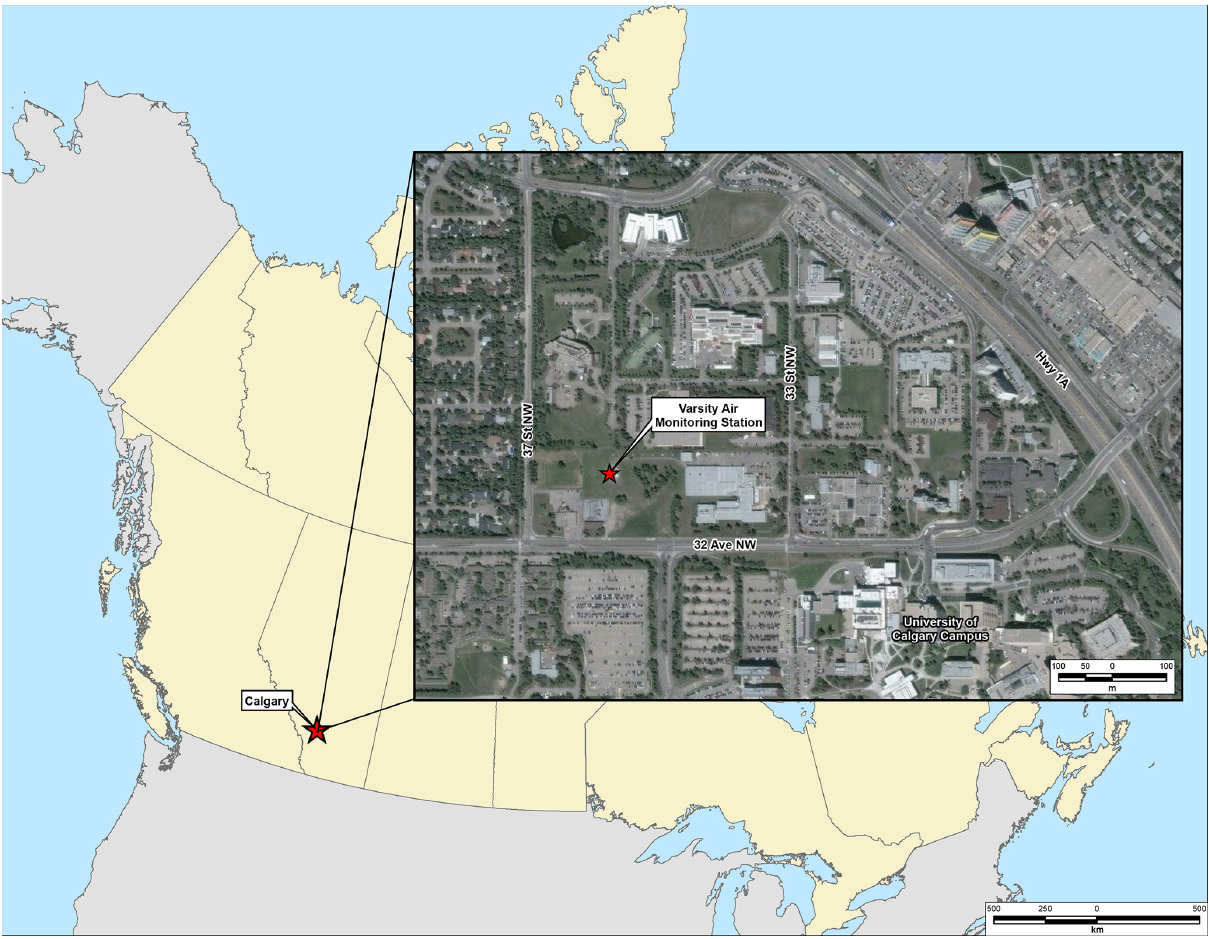
Figure 2. Location of the Varsity air monitoring station. The map was created using ArcGIS ® . The administrative boundaries in Canada and imagery data were provided by Natural Resources Canada (2020) and DigitalGlobe (2019).